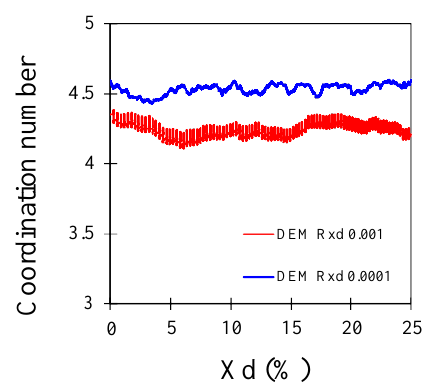
Fig. 9 . Coordination number variation for two rates of